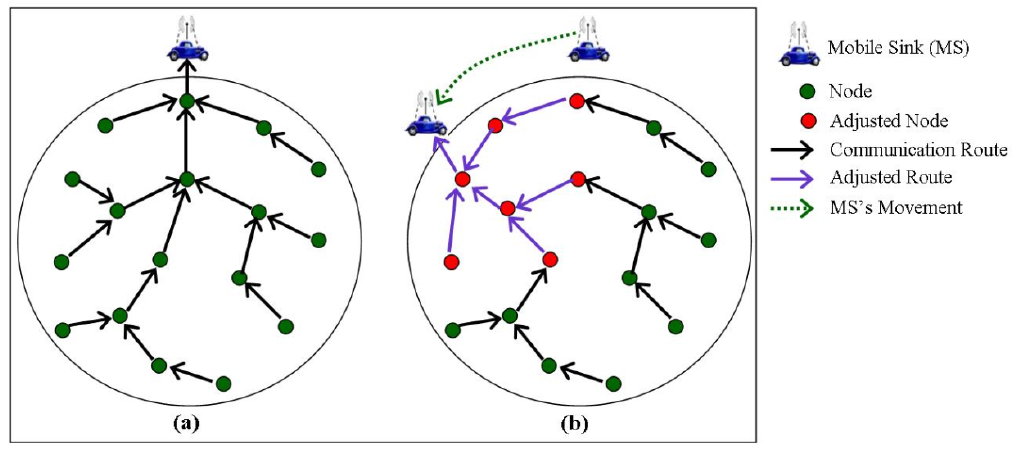
Figure 6. Partial tree readjustment in VCCSR upon sink mobility